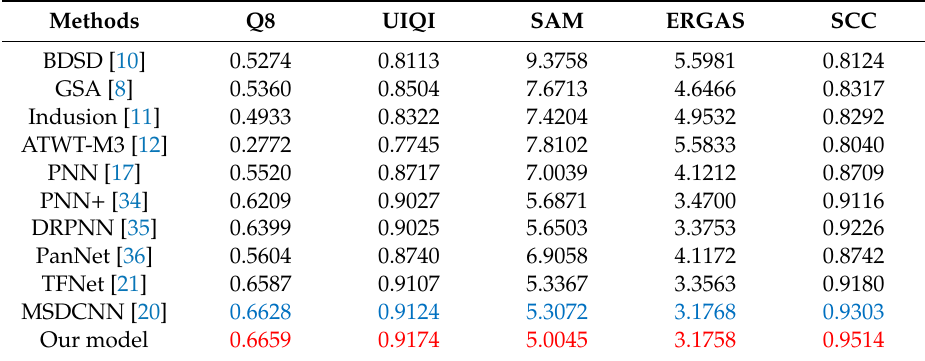
Table 9. Quantitative evaluation results of di ff erent methods on the WorldView-2 dataset. The best and the second best results are in red and blue,